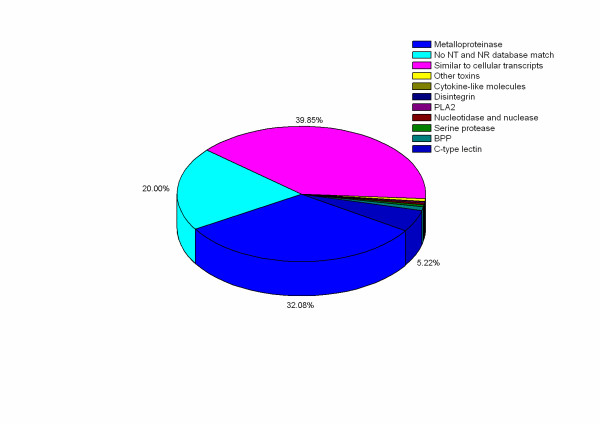
Distribution of ESTs from D. acutus venomous gland according to their cDNA products. The percentage of ESTs classification more than 1.00% is indicated.